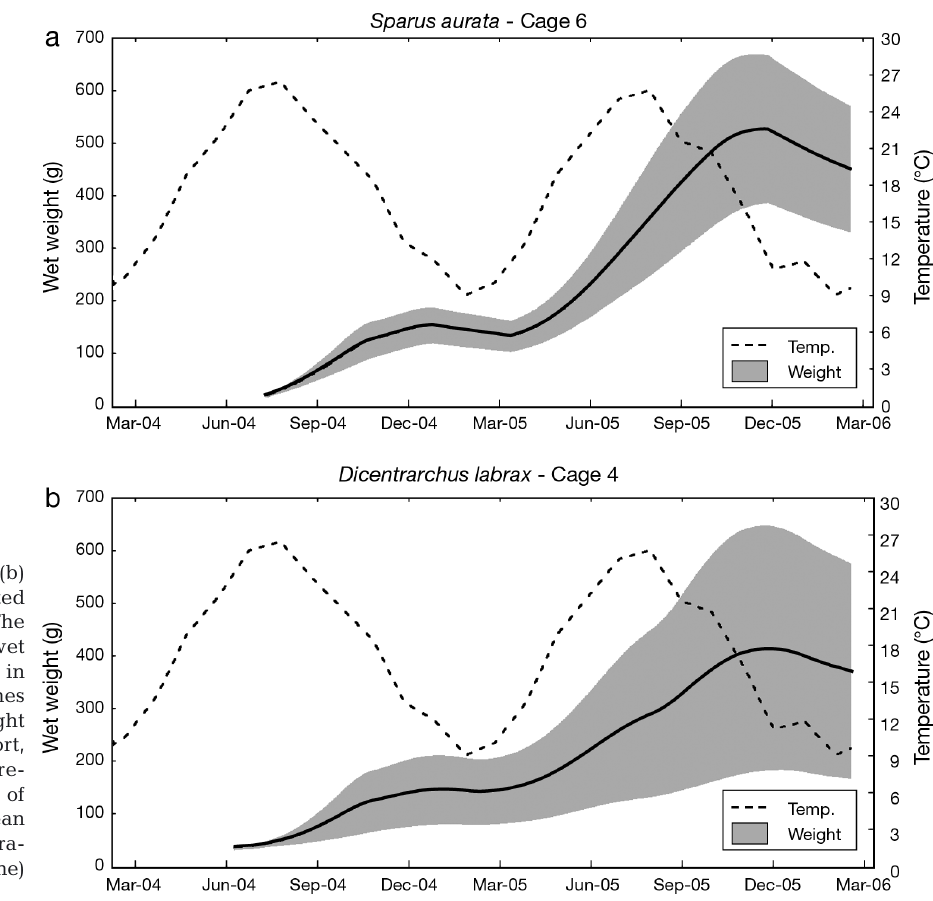
lower C:P values (Fig. 6d), was localized underneath the cages. A gradient in C:N (Fig. 6c) was distributed along a transect with a WNW−ESE orientation. C:P values were always higher than the Redfield ratio